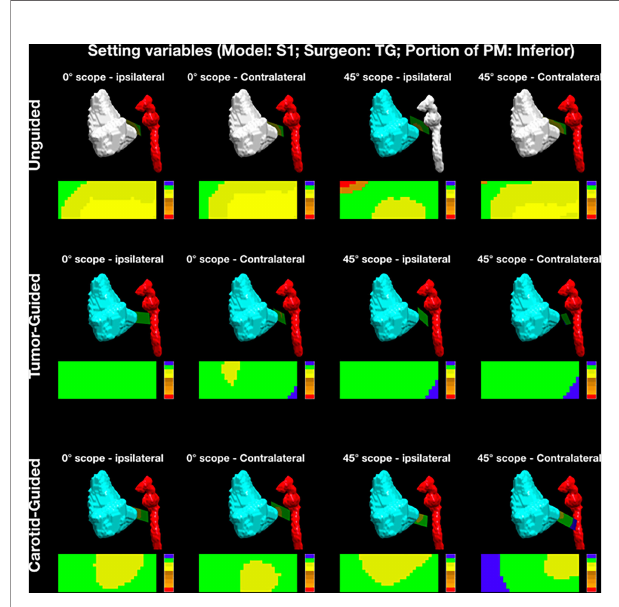
FIGURE 4 | Example of the analysis of posterior margin delineation. Each point of the isolated area was classi fi ed as follows: “ red ” ( R ), into the internal carotid artery (ICA); “ orange 1 ” ( O1 ), <2 mm from the ICA and into the tumor; “ orange 2 ” ( O2 ), <2 mm from the ICA and <5 mm from the tumor; “ orange 3 ” ( O3 ), <2 mm from the ICA and 5 – 10 mm from the tumor; “ orange 4 ” ( O4 ), <2 mm from the ICA and >10 mm from the tumor; “ yellow 1 ” ( Y1 ), >2 mm from the ICA and into the tumor; “ yellow 2 ” ( Y2 ), >2 mm from the ICA and <5 mm from the tumor; “ green ” ( G ), >2 mm from the ICA and 5 – 10 mm from the tumor; and “ blue ” ( B ), >2 mm from the ICA and >10 mm from the tumor. PM , posterior margin.